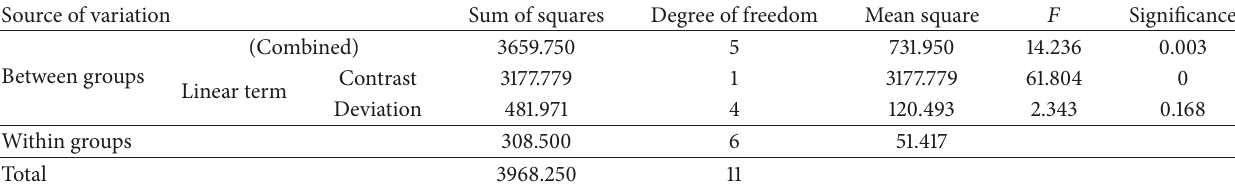
Table 8: ANOVA: single factor between the groups of different storage time on rutting factor. Source of variation